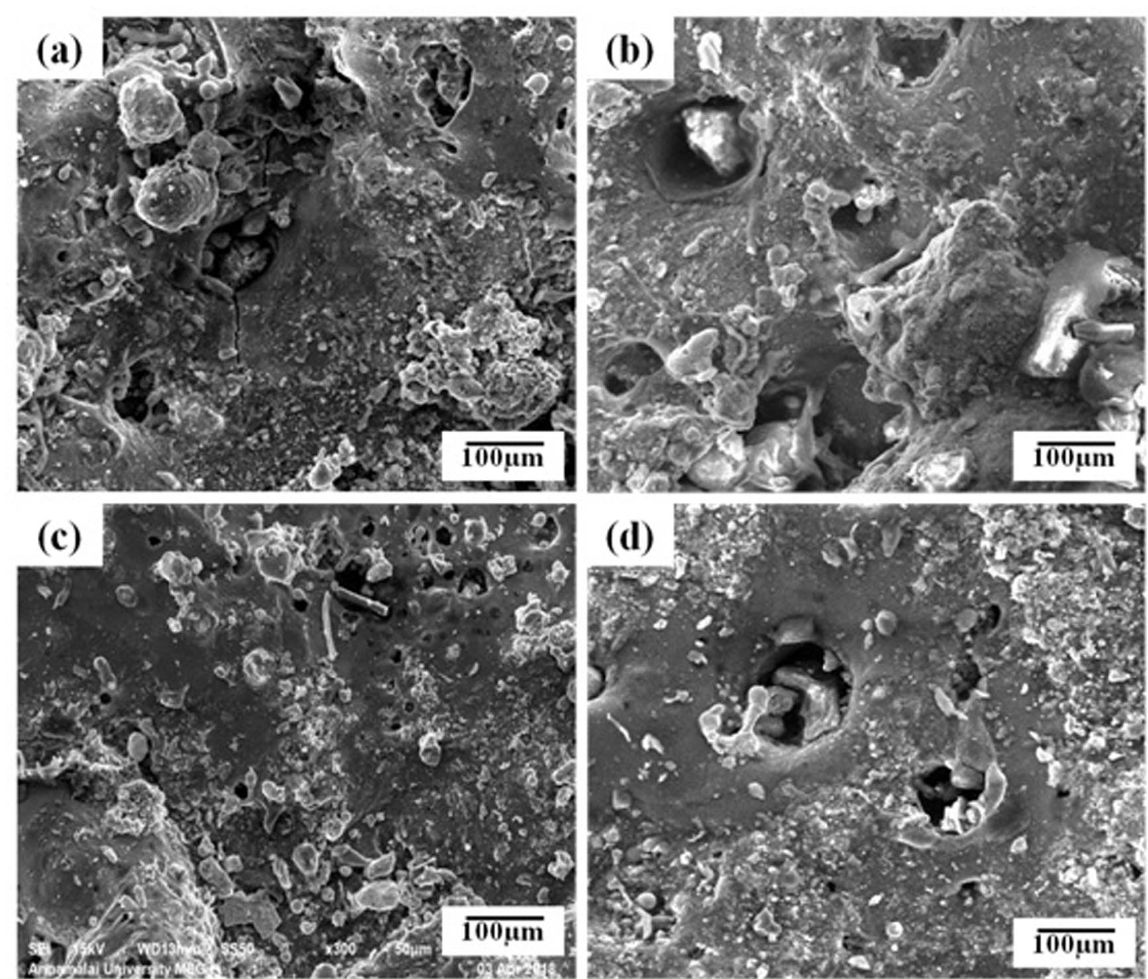
Figure 6: SEM microstructure (a) cracks at partially sintered electrode with low current; (b) crater at high current; (c) small sized voids at fully sintered electrode with higher current; (d) Bigger